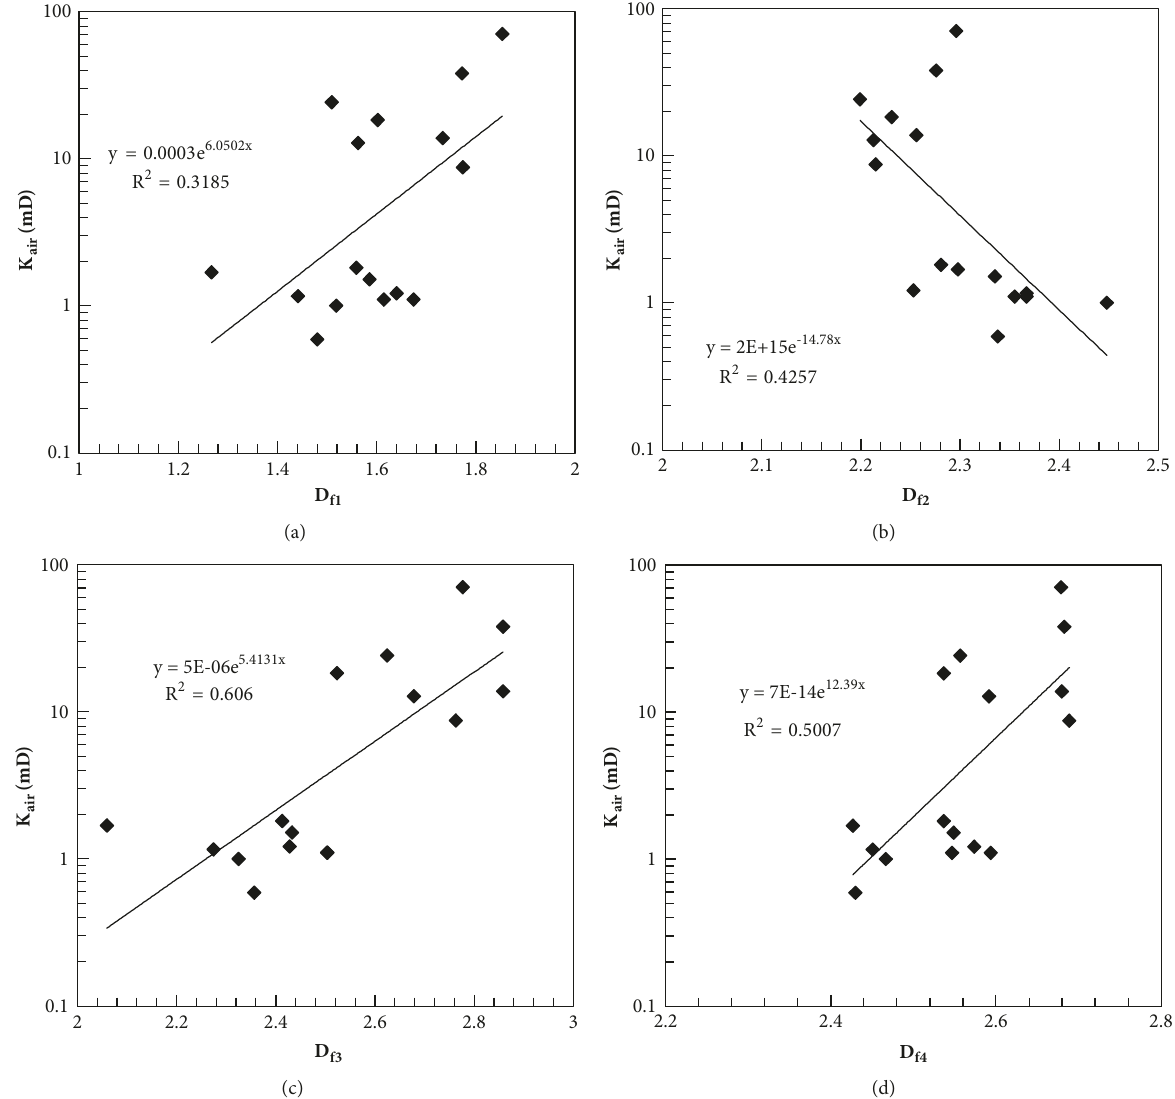
Figure 6: The correlation between the air permeability 𝐾 𝑎𝑖𝑟 and the fractal dimensions calculated from different